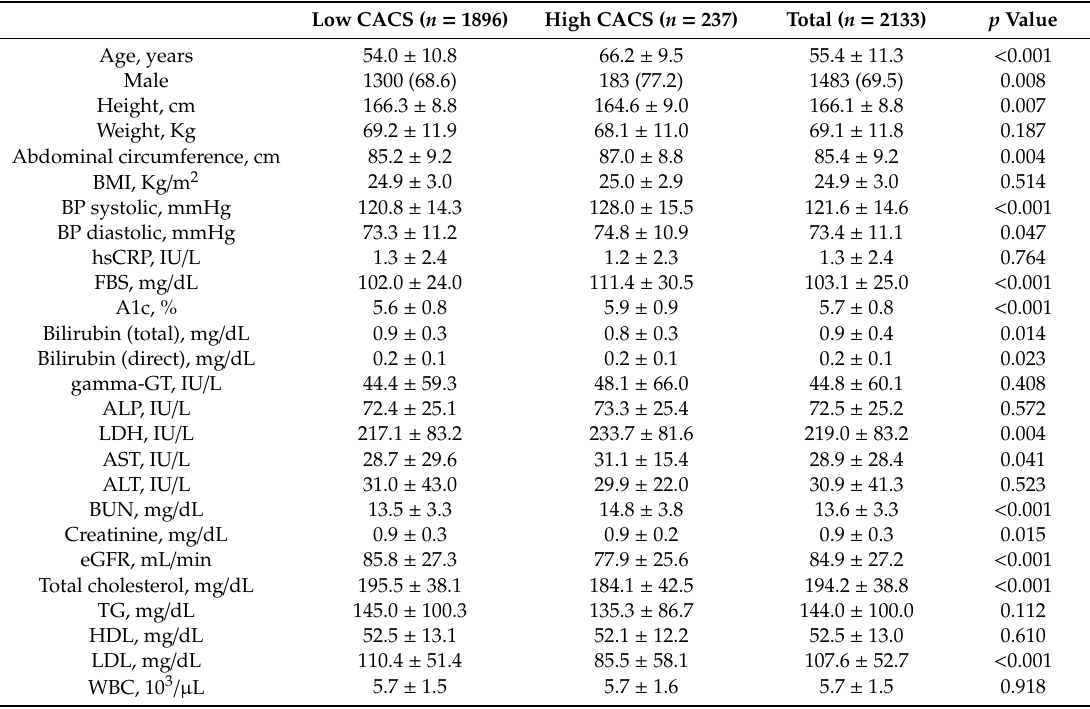
Table 1. Baseline characteristics of the total study